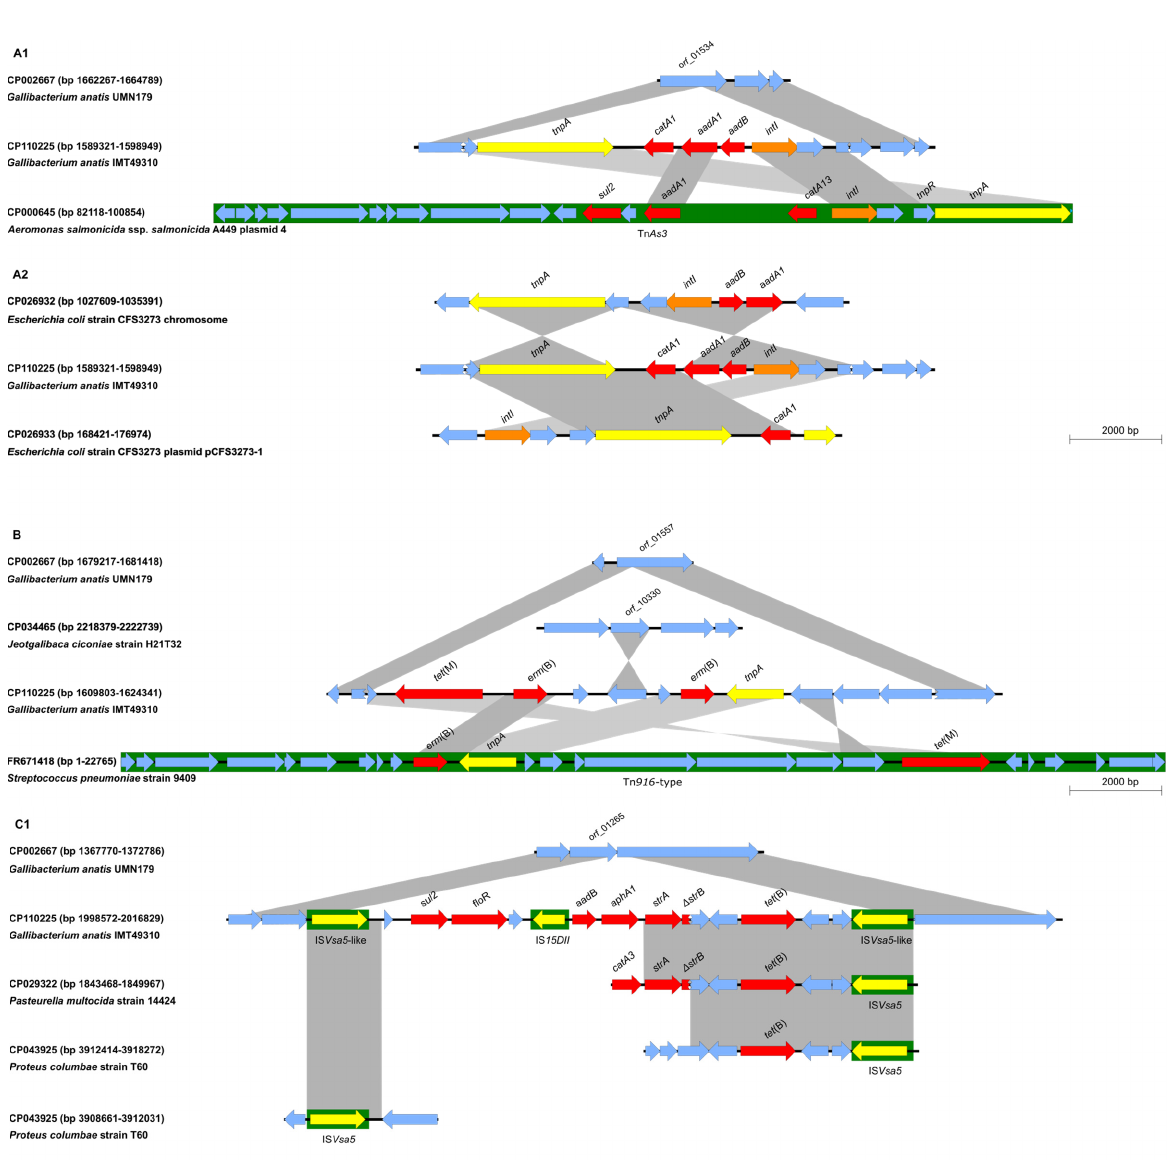
Figure 1. Organization of the resistance gene regions of G. anatis IMT49310. Open reading frames are shown as blue arrows, resistance genes are marked in red, transposase genes in yellow, and integrase genes in orange. The arrowheads indicate the direction of transcription. IS or integrative and conjugative elements and transposons are depicted as green boxes, and grey shading indicates similarities between sequences. ( A1 , A2 ) Schematic representation and alignment of resistance gene region I of G. anatis IMT49310 (CP110225) with sequences CP002667 ( G. anatis UMN179), CP000645 ( Aeromonas salmonicida ssp. salmonicida A449 plasmid 4), CP026932 ( Escherichia coli strain CFS3273 chromosome) and CP026933 ( E. coli strain CFS3273 plasmid pCFS3273-1) from GenBank. ( B ) Schematic representation and alignment of resistance gene region II of G. anatis IMT49310 (CP110225) with sequences CP002667 ( G. anatis UMN179), CP034465 ( Jeotgalibaca ciconiae strain H21T32 chromosome) and FR671418 ( Streptococcus pneumoniae strain 9409 Tn 916 -type integrative and conjugative element) from Genbank. ( C1 , C2 ) Schematic representation and alignment of resistance gene region III of G. anatis IMT49310 (CP110225) with sequences CP002667 ( G. anatis UMN179), CP029322 ( Pasteurella multocida strain 14424), CP043925 ( Proteus columbae strain T60 chromosome), and MW391932 ( Haemophilus parainfluenzae strain HUB10329) from GenBank.